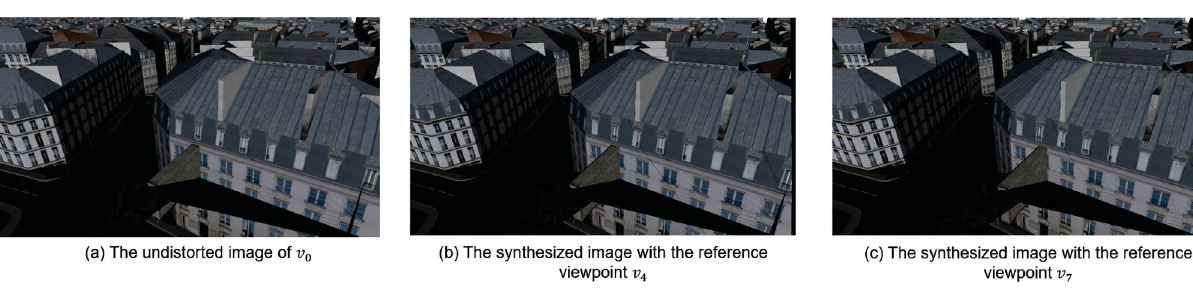
Fig. 10 Visual quality of synthetic images with different predicted reference viewpoints. (a) Undistorted image of v 0 . (b) Synthetic image of v 0 using the reference view of v 4 , as suggested by MSE. (c) Synthetic image of v 0 using the reference view of v 7 , as suggested by our metric. total of 25 reference viewpoints are suggested by MSE,